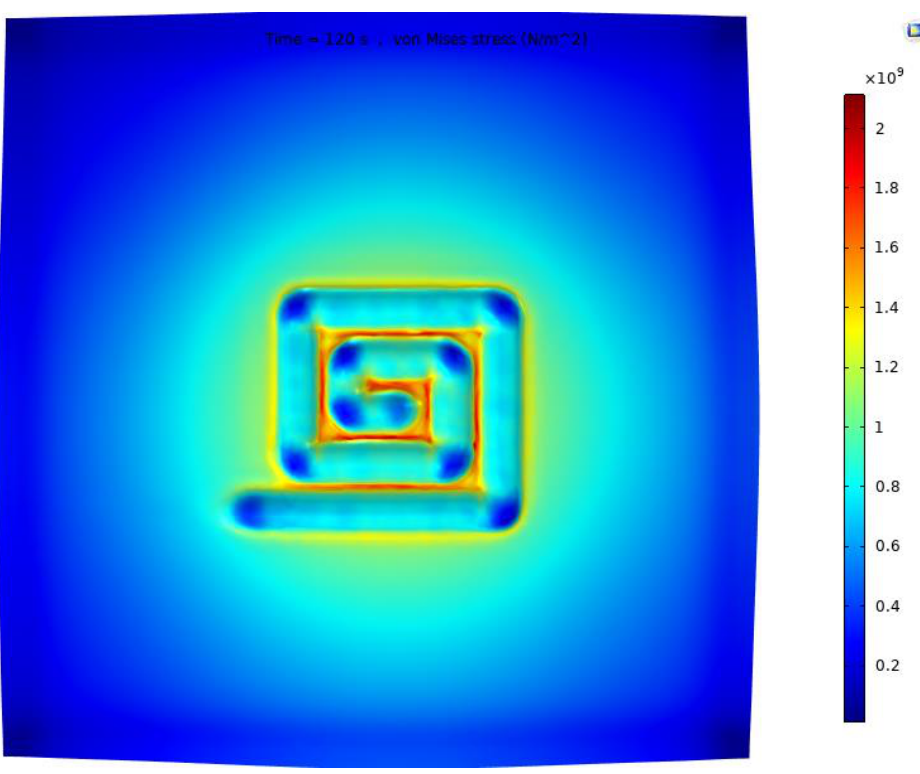
Figure 8. Distribution of von Mises stress (in N/m 2 ) after 120 s (track is finished and system is being cooled). Deformations are also depicted.